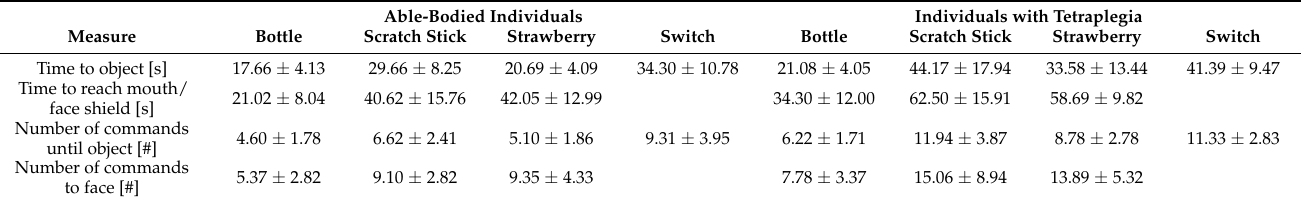
Table 4. Metrics for the tests with able-bodied individuals and users. Mean and standard deviations of each metric of the described tests for both individuals with tetraplegia and able-bodied individuals.